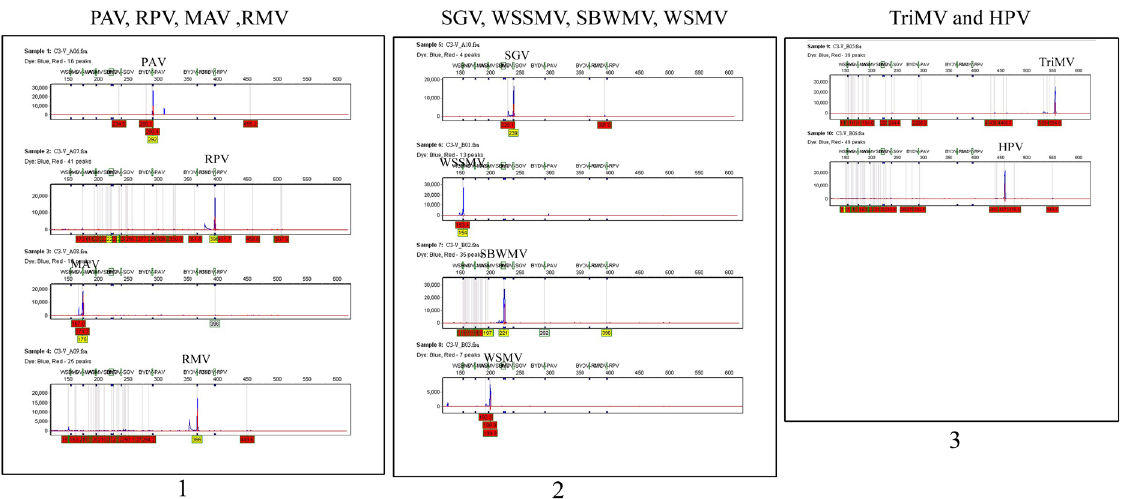
Figure 4. Electropherogram for each of the ten viruses. Individual RT-PCRs with each set of virus- specific primers were run on capillary electrophoresis using an ABI 3130xl. Each separate capillary contained the sample from an individual PCR (blue peak) and the GeneScan 500 LIZ standards (red peak) in deionized formamide. The first panel on the left (1) shows the results for the viruses PAV, RPV, MAV, and RMV, (2) identifies the other 4 viruses SGV, WSSMV, SBWMV, and WSMV, while (3) shows the additional two new viruses in the assay, TriMV and HPV. All these ten viruses were identified by separate peaks (blue) very close to the amplicon size identified in an agarose